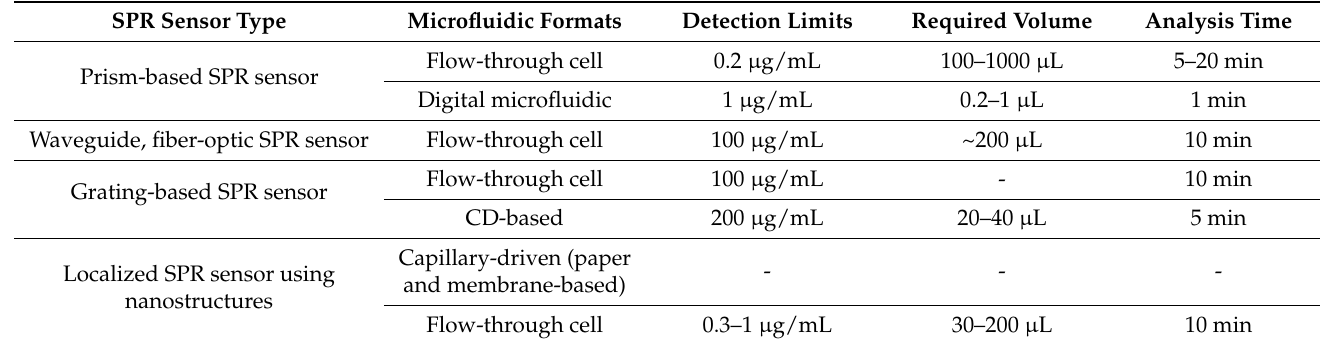
Table 2. Summary of various microfluidic SPR sensors formats.